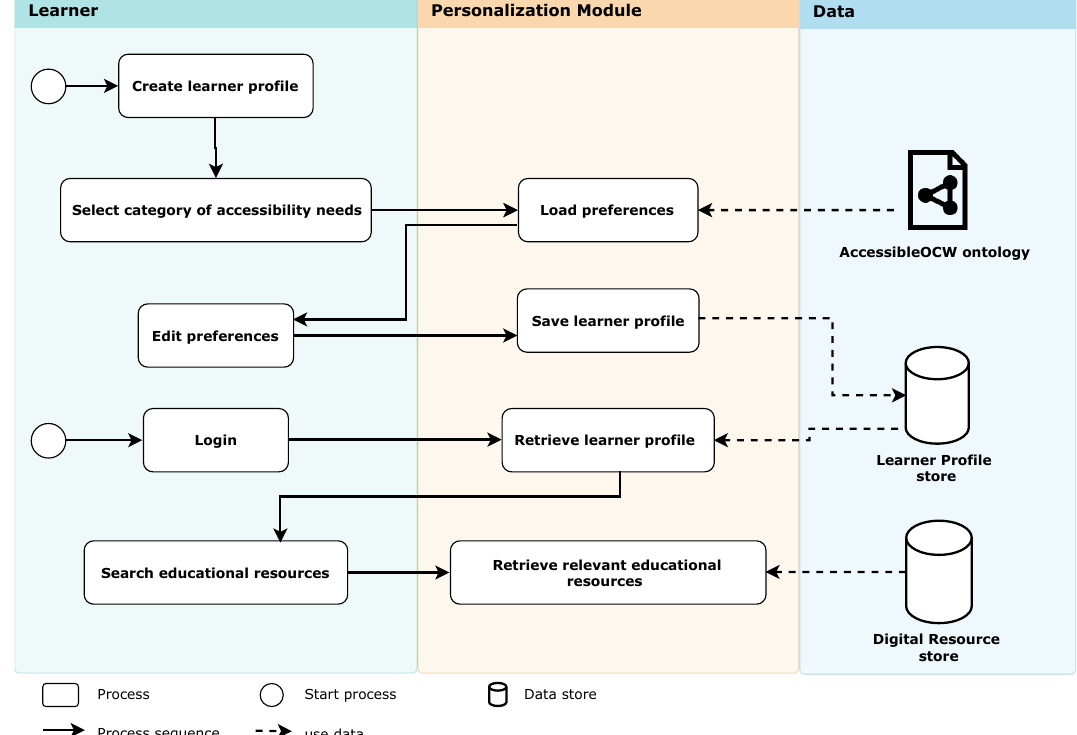
Figure 1. Process model of the proposed